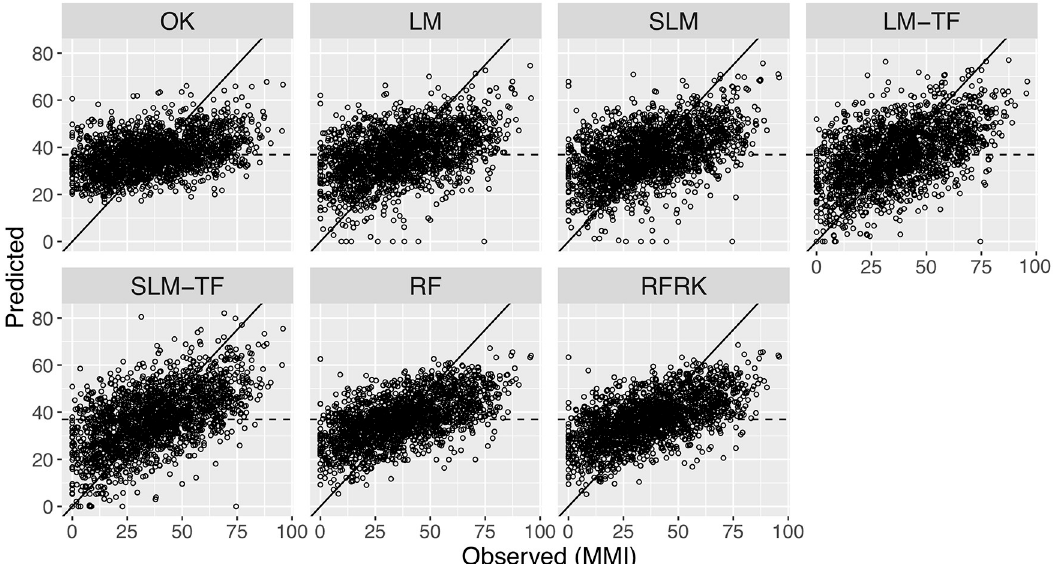
Fig 4. Scatter plots of predicted versus observed MMI values. Predictions are from 10-fold cross-validation. The 1-1 line (solid) and mean observed MMI value (36.9; dashed horizontal line) are also shown in each panel. Labels for the seven models are defined in Table 1 and the text.